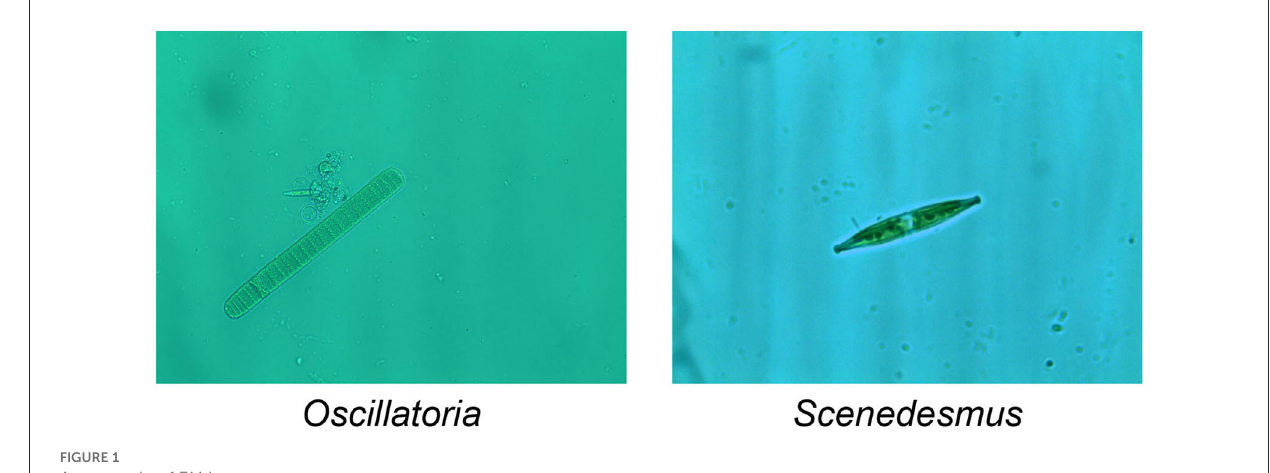
FIGURE1 An example of EM